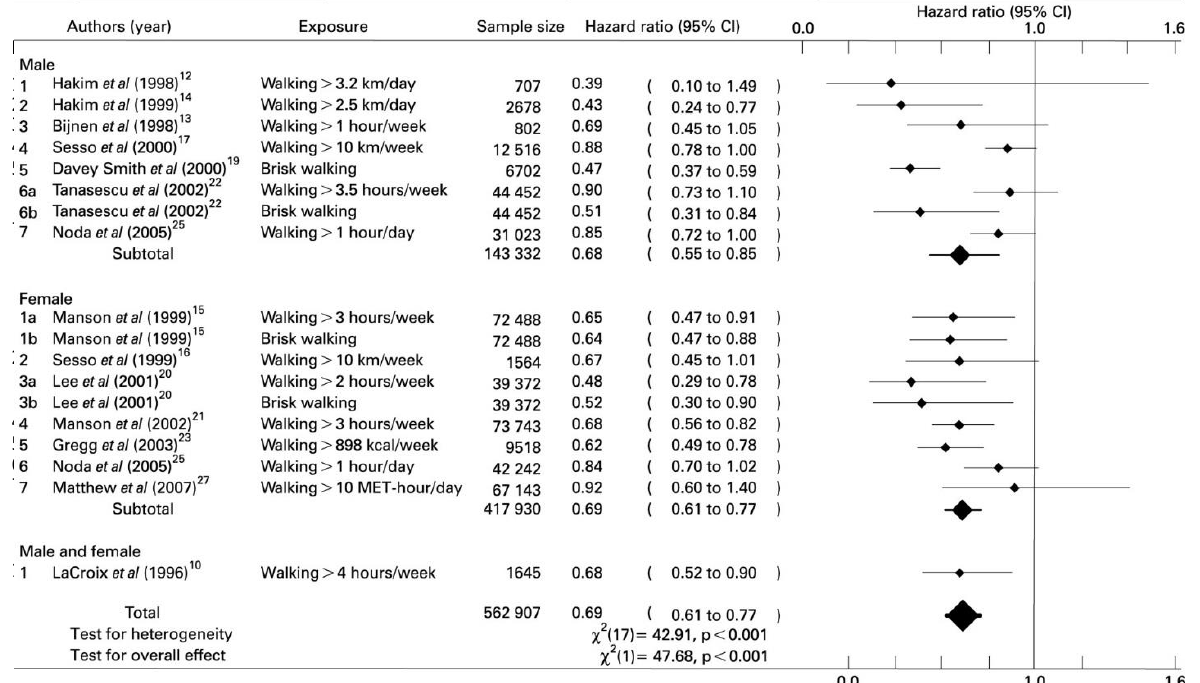
Figure F6-4. The Association Between Walking and Cardiovascular Mortality Risk in Men and